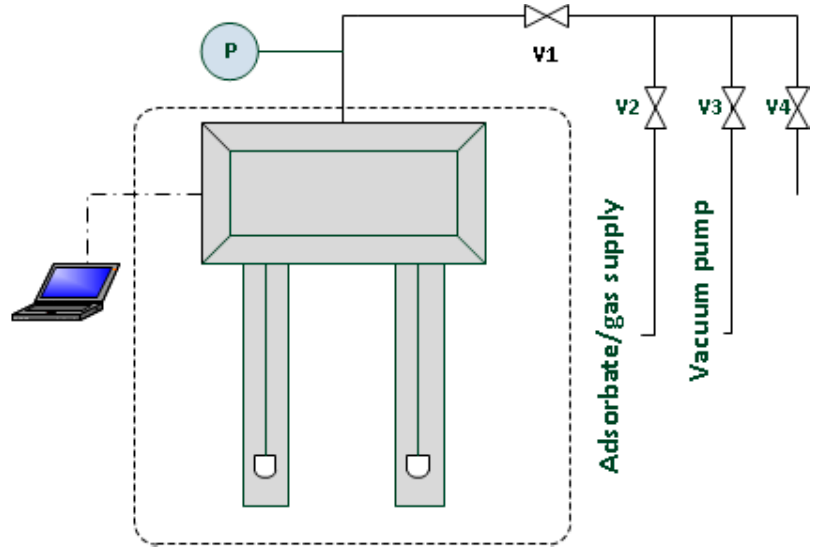
Figure 3. Apparatus used for measurements of hydrogen adsorption-desorption (V1-V4-valves, P- pressure transducer).